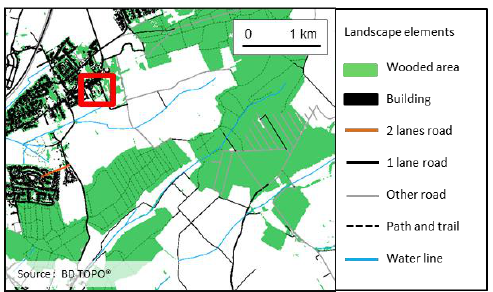
Figure 5. The study site in the east of France covers 15 km². It is mainly forested with urbanised area on the west part. The red rectangle corresponds to the area shown in Figure